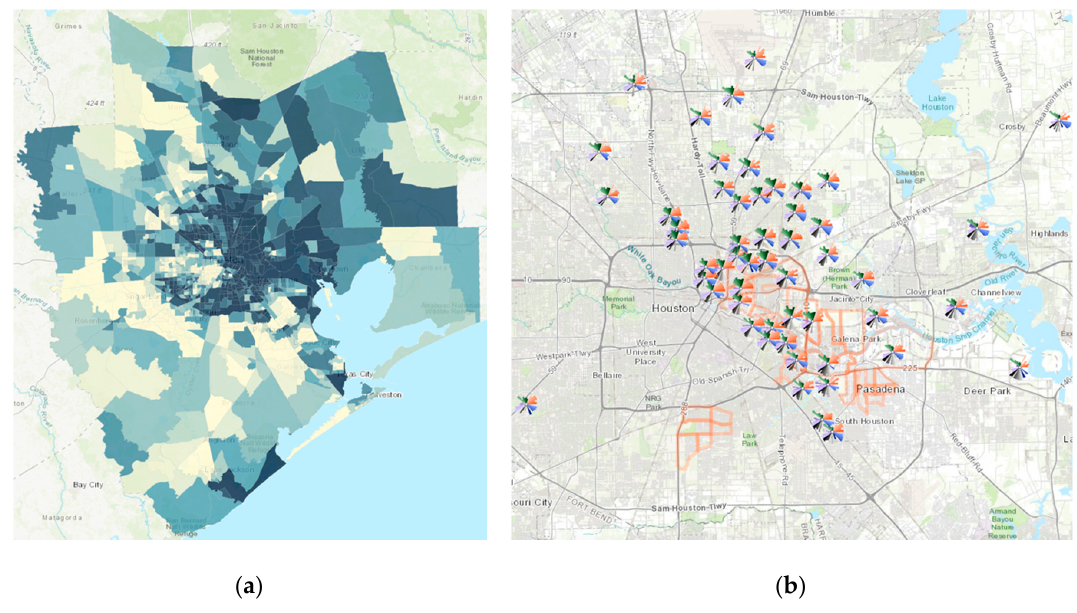
Figure 4. Map of spatial distribution of overall ToxPi scores across all 1090 census tracts ( a ). Overlay of ToxPi visualizations zoomed into the area containing the top 5% ToxPi scoring census tracts, along with census tracts in partner communities (orange outlines) for reference ( b ).